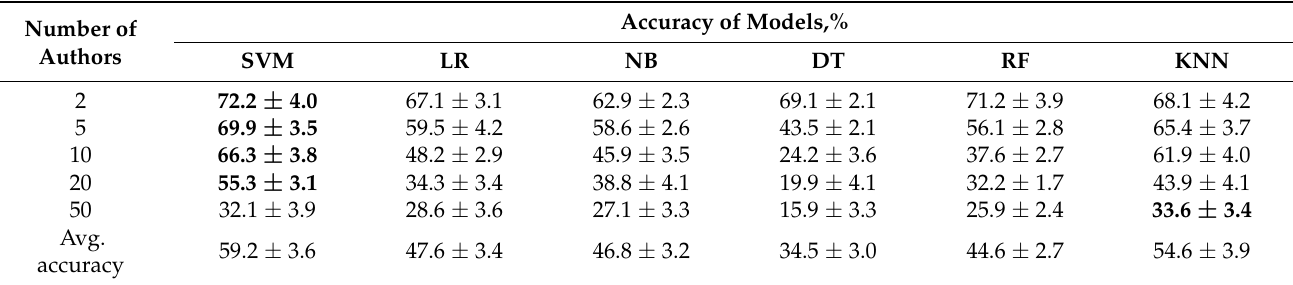
Table 7. Results of author identification using ML trained on the feature space.